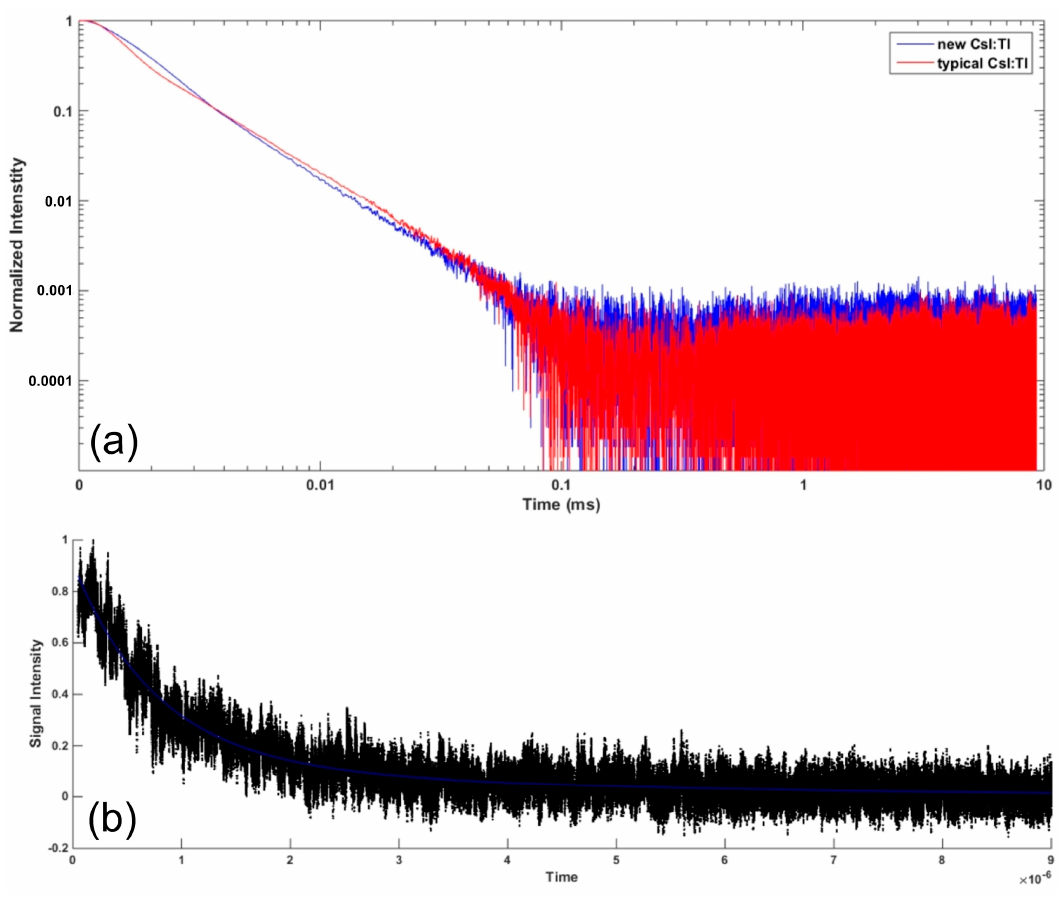
Figure 5. CsI:Tl characterization done at MGH: ( a ) Afterglow measurement. ( b ) Decay time measure- ments, resulting in decay time constants of 778 ns (76%) and 4.1 µ s (24%). 3.2. NaI:Tl The 1.5-inch diameter NaI:Tl crystal boule grown at XI, Inc. is presented in Figure 6a, with a processed ∅ 1” × 1” sample cut from the boule shown in Figure 6b. A sample